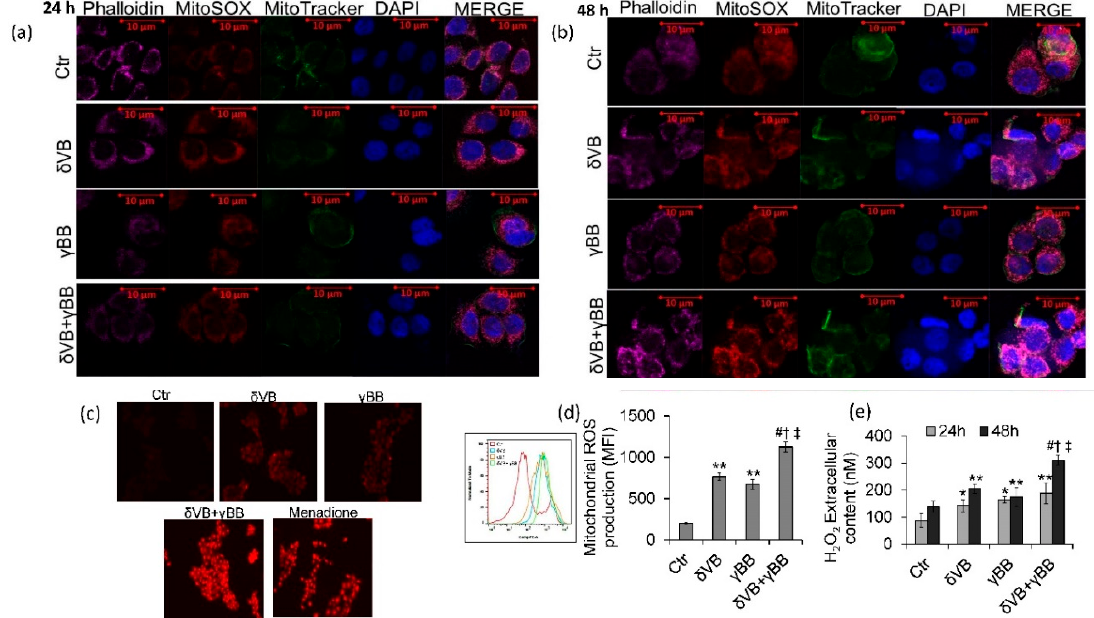
Figure 6. Mitochondrial stress assessment. ( a , b ). Representative images of confocal laser